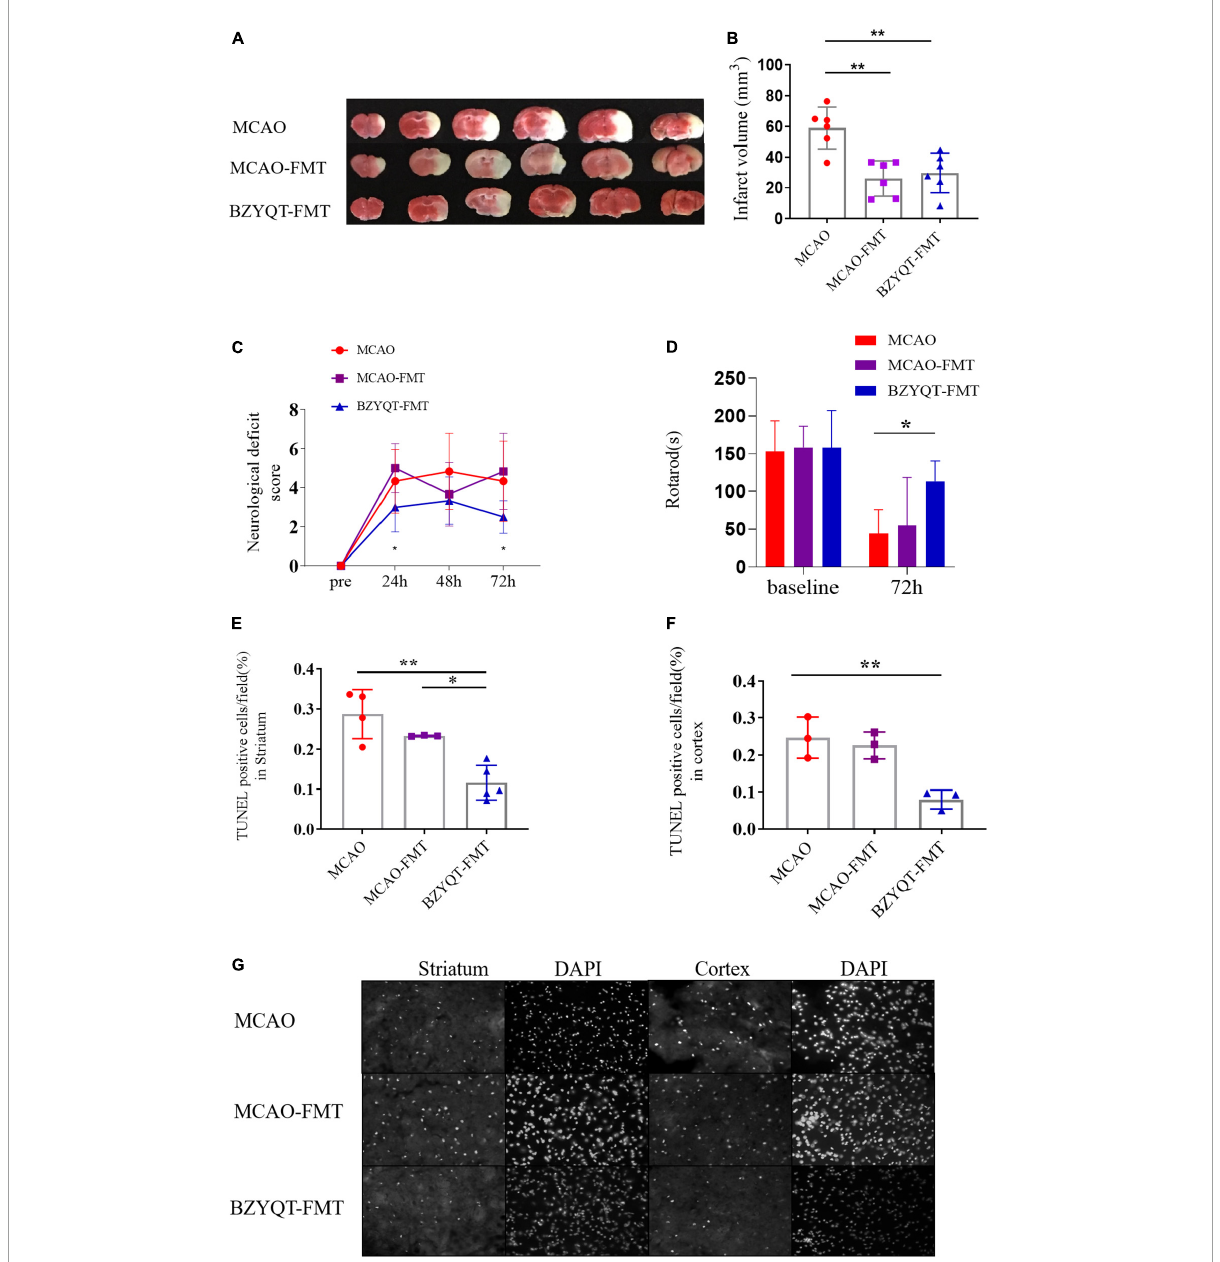
FIGURE4 Improvement of ischemic stroke by microbiota transplantation. Panel (A) is the volume of cerebral infarction at 72 h after the operation ( n = 6). Panel (B) is the ImageJ quantitative analysis of cerebral infarction volume. (C) Compare analysis of neurological functional deficits before and 24, 48, and 72 h after MCAO. ( n = 6). Panel (D) is the rotarod motor function of mice 72 h after operation ( n = 6). Panel (E) is the statistics of apoptotic cells in the cortex near the ischemic penumbra detected by the TUNEL kit ( n = 3). Panel (F) is the statistics of apoptotic cells in the striatum near the cerebral infarction ( n = 4/3/5). Panel (G) is the analysis of apoptosis-positive cells in the cortex and striatum near the cerebral infarction. Five images of different fields of view were collected at each site, and the ratio of apoptosis-positive cells/nuclei was counted. * p < 0.05 and ** p < 0.01. Data are expressed as mean ± standard